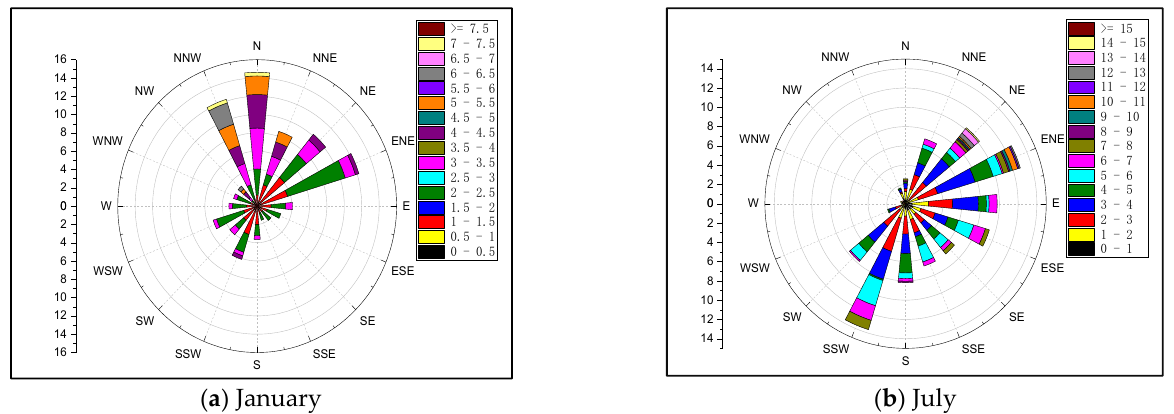
Figure 10. Distributions of wind directions in January and July 2016. ( a ) the distributions of wind directions in January, ( b ) the distributions of wind directions in July.